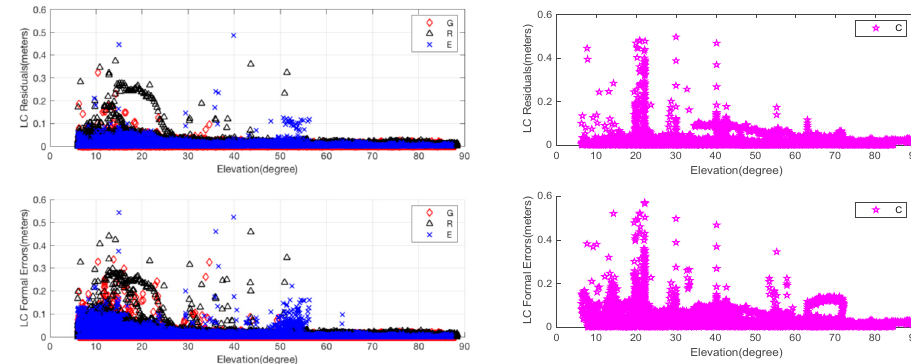
Figure 4. EM-PPP carrier phase combination (LC) residuals and formal errors of JFNG station at 50th iteration: Left two pictures are the LC residuals and formal errors (square root of the observation covariance matrix) for GPS, Glonass and Galileo, respectively. Similarly, the right two pictures show the LC residuals and formal errors for